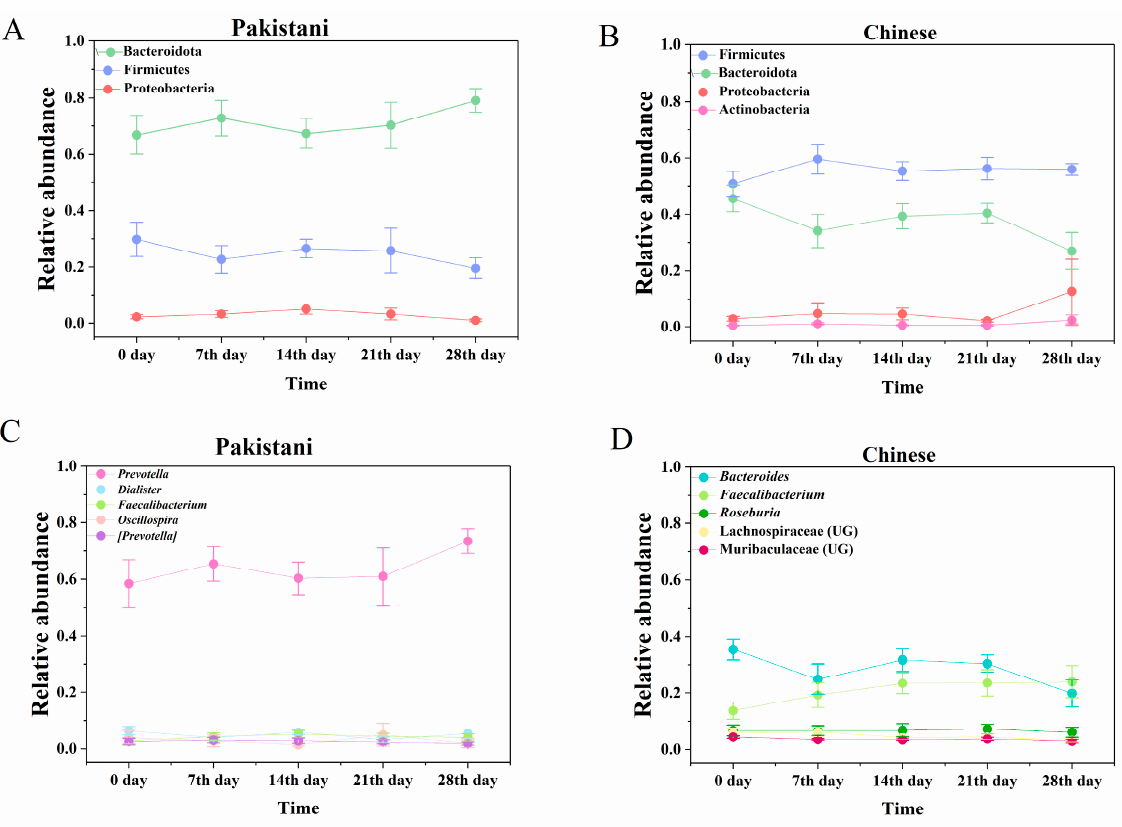
Figure 1. The same letters meant no statistical difference ( p > 0.05) and different letters meant statistical difference ( p < 0.05). Some dominant phyla ( A , B ) and genera ( C , D ) were compared in all time points based on the relative abundance via one-way ANOVA. Neither phyla nor genera were different among these 5 time points ( p > 0.05).